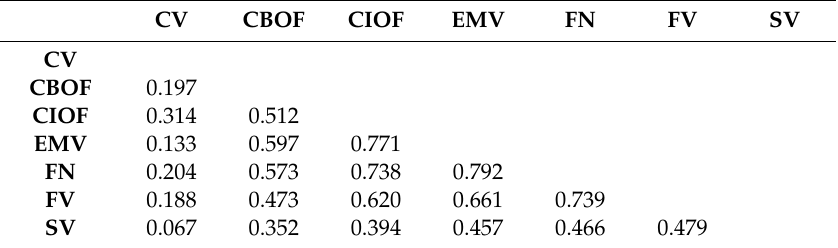
Table 3. Discriminant validity